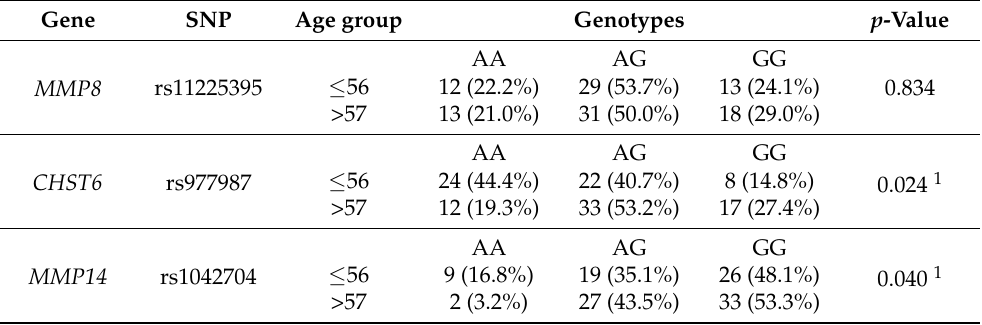
Table 4. Distribution of genotype and allele frequencies for polymorphisms at MMP8 , CHST6 , and